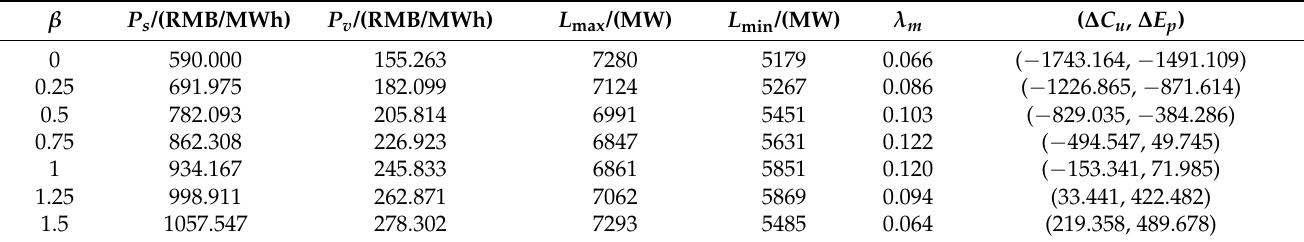
Table 3. Performance of different pull-off ratios.